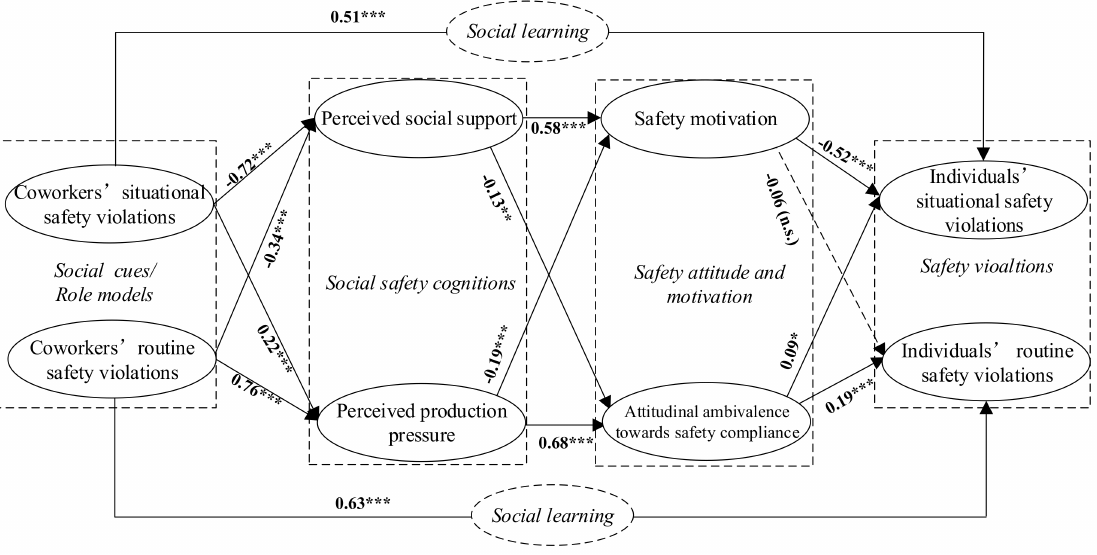
= 1.832; CFI = 0.965; df